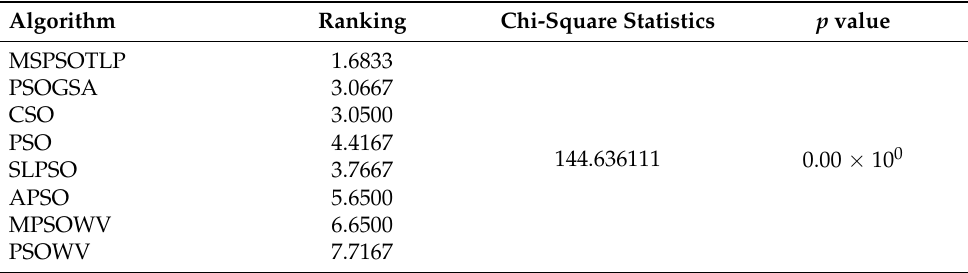
Table 7. Average ranking and p-value produced by Friedman